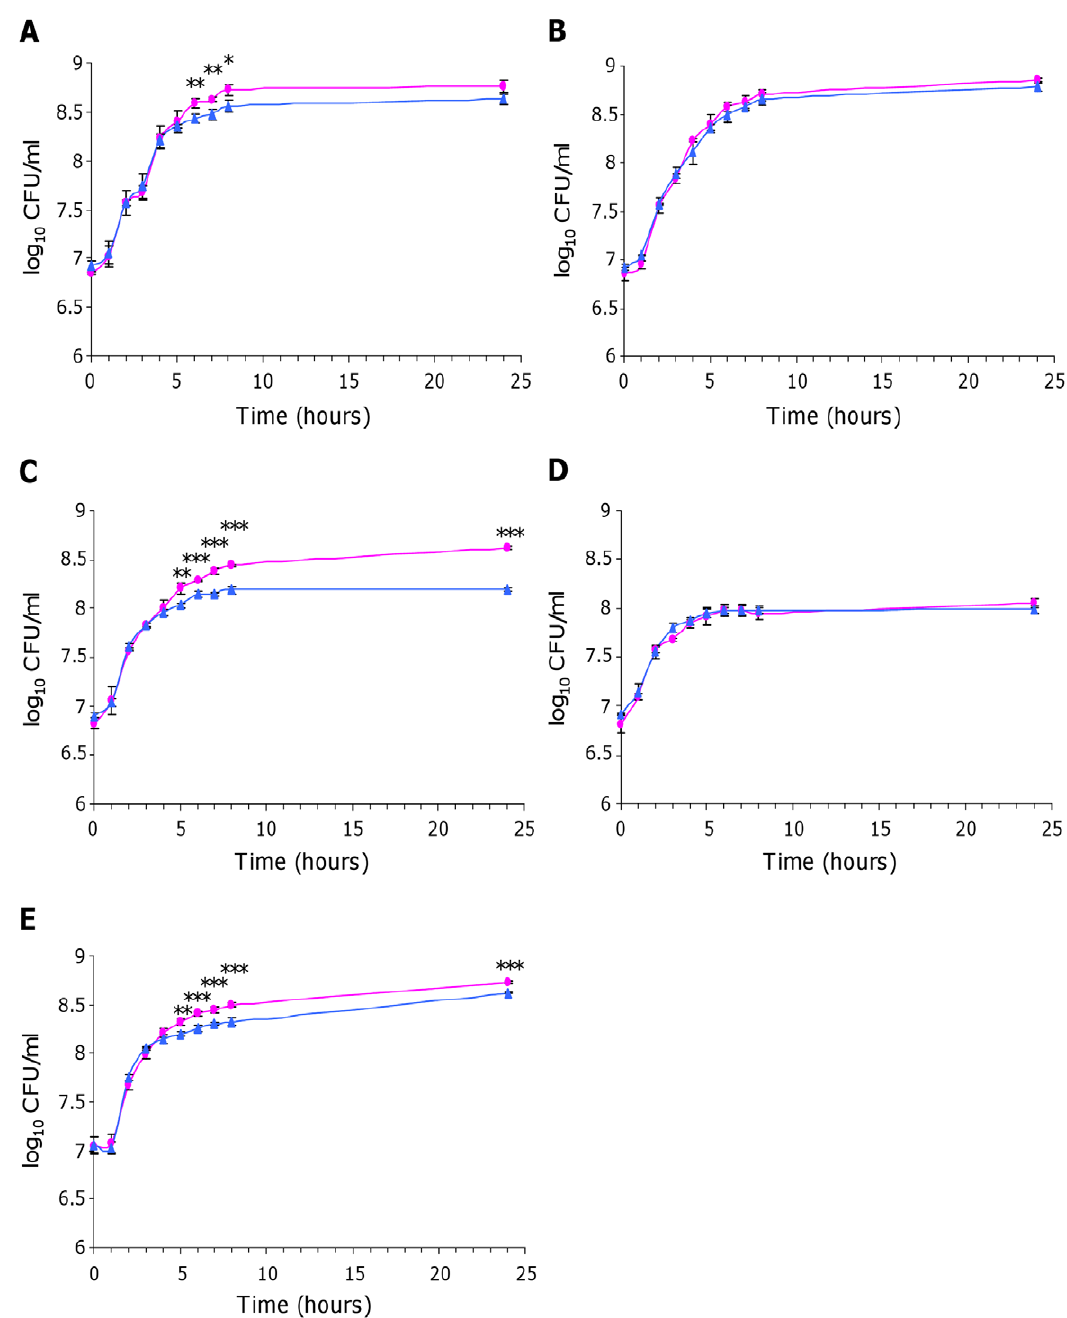
Figure 8. Competition between E.coli strains BEN2908 and BEN2908 D fosT to grow in the presence of extracts of chicken intestine. Growth curves (log 10 CFU/ml) of strains BEN2908 (pink circle) and BEN2908 D fosT (blue triangle) grown without shaking at 37 u C in M9 minimal medium supplemented with (A) intestinal mucus from the ileum at 2 mg/ml of proteins, (B) intestinal mucus from the colon at 2 mg/ml of proteins, (C) 2% of cecal content from axenic chicken, (D) 2% of cecal content from SPF chicken, (E) 4% of cecal content from axenic chicken supplemented with cecal bacteria from SPF chicken. The average values and standard deviations result from three independent experiments. Asterisks indicate significant differences in mean number of CFU between BEN2908 and BEN2908 D fosT determined by a Student’s t -test. *** P , 0.005; ** P , 0.02; * P , 0.05.